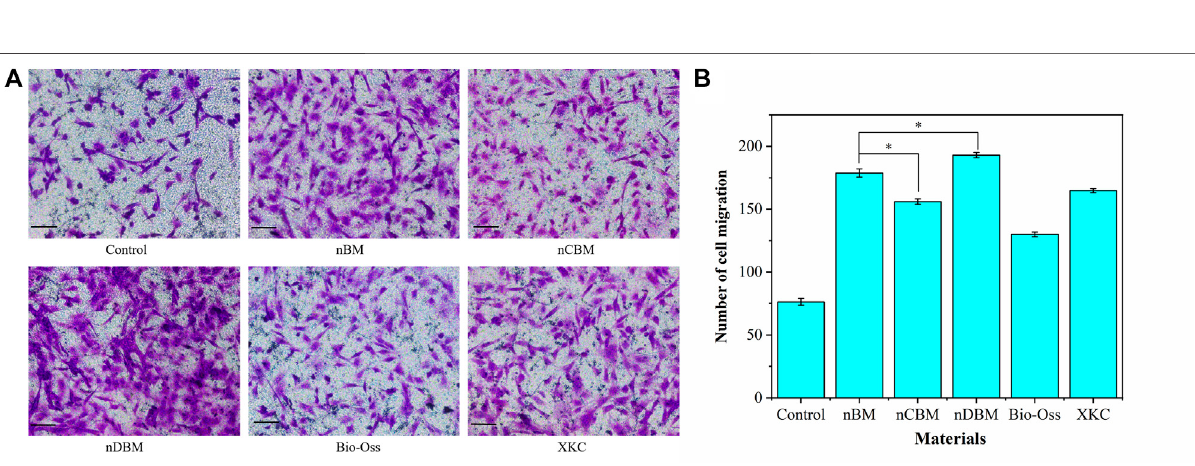
Frontiers in Bioengineering and Biotechnology |